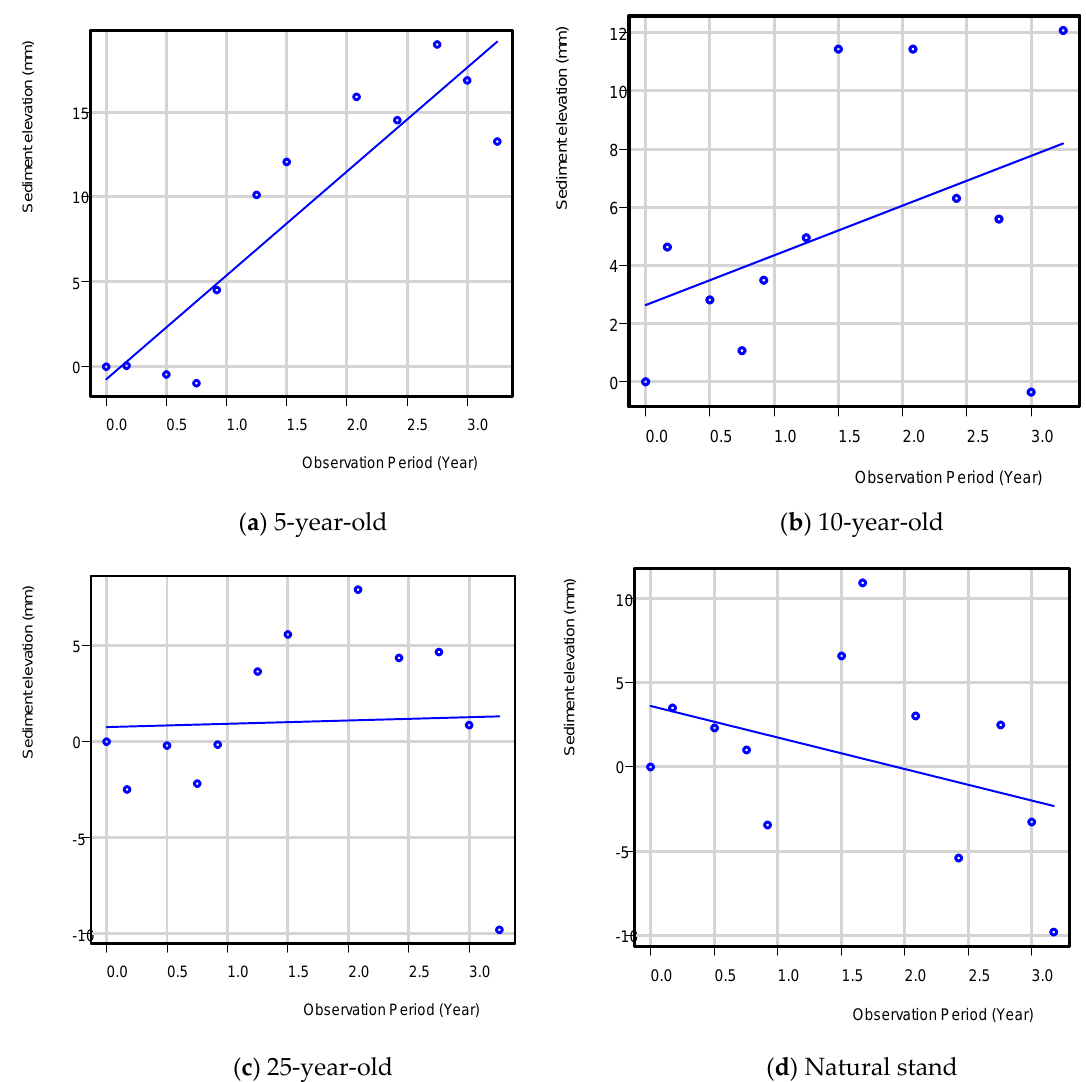
Figure 2. Sediment surface elevation change in the 5-, 10-, and 25-year-old mangrove plantations and the reference natural mangrove stand, Quezon province.